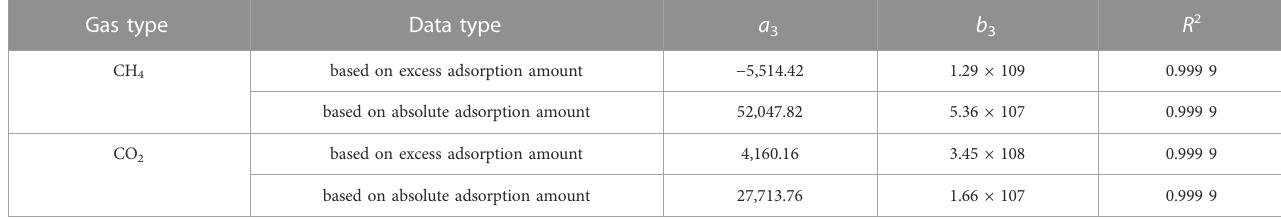
TABLE 4 The linear fi tting parameters of isosteric heat and adsorption capacity. Gas